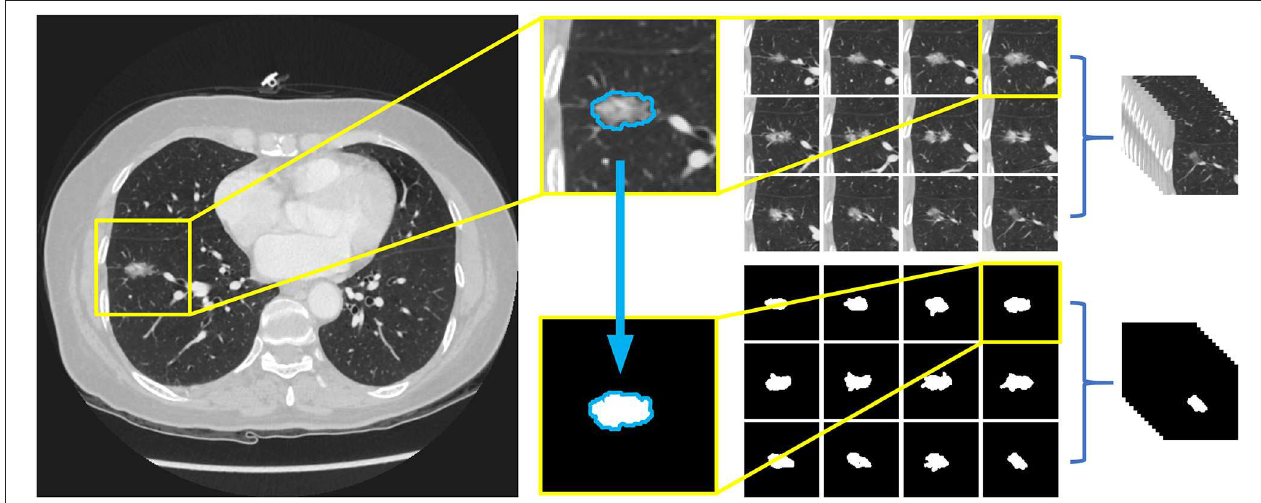
FIGURE 2 | Preprocessing of image data and the arrangement of dataset. Twelve slices chosen for labeling and 12 label files were trimmed to a size of 96*96 pixels with nodules in the middle, and then saved as Dicom format in separate directories, both named with the patients’